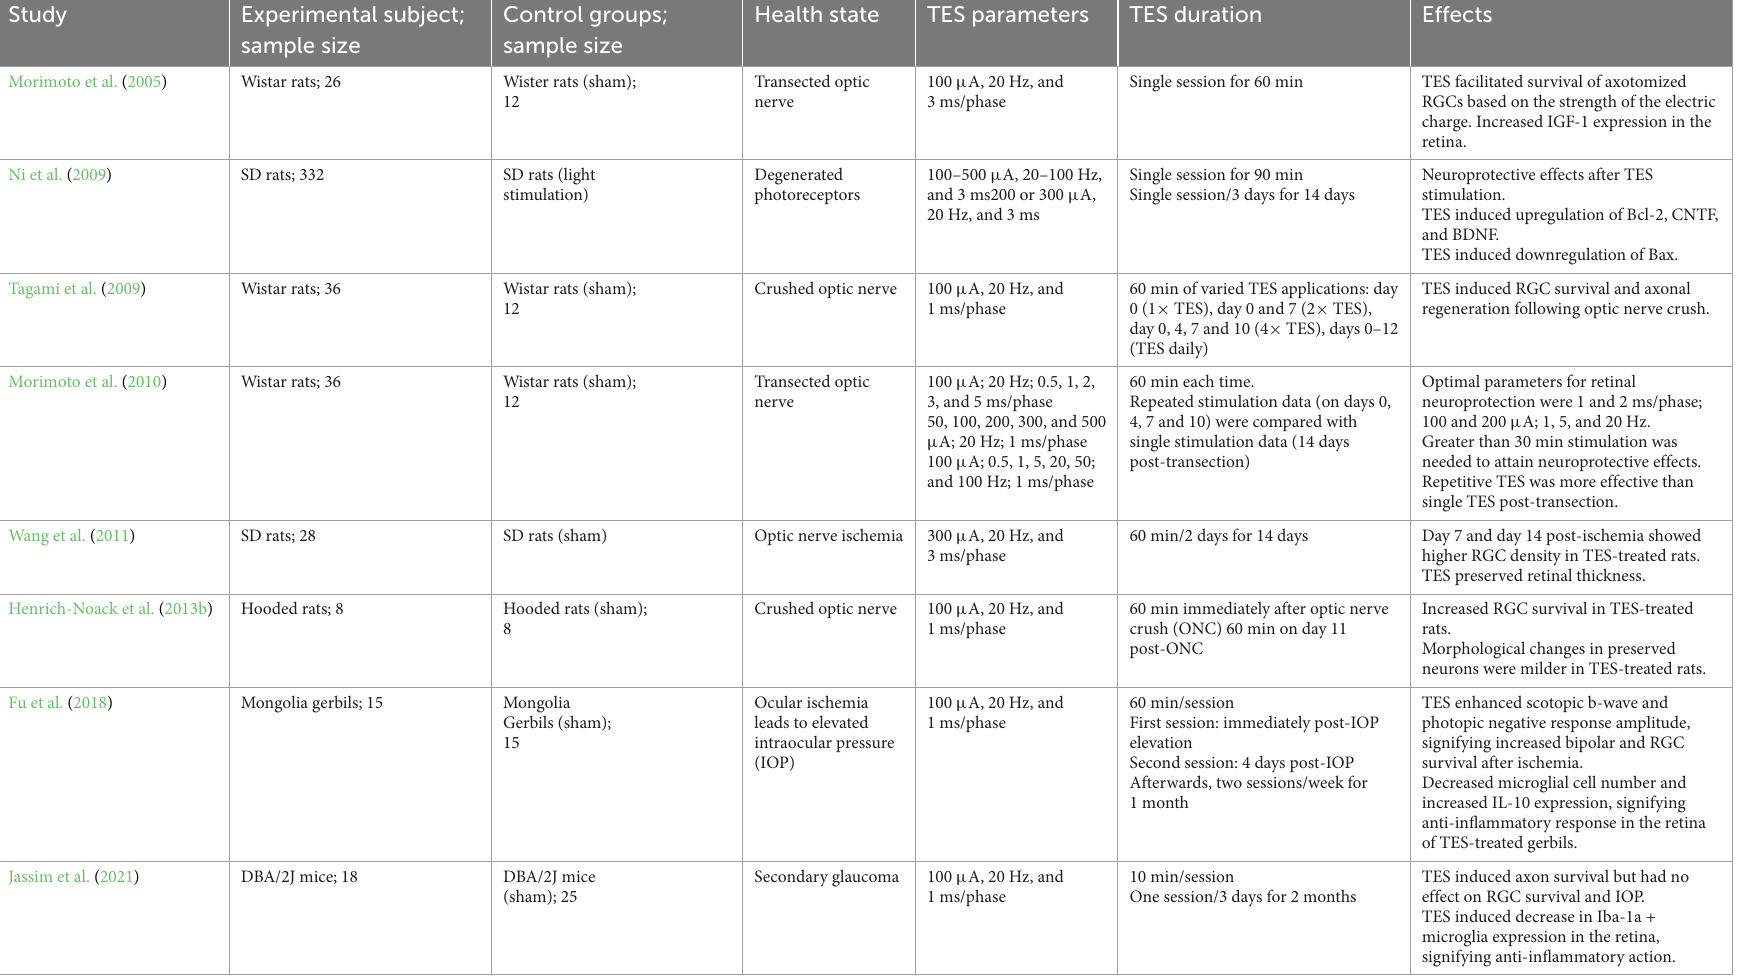
TABLE 1 Summary of preclinical studies on the effects of TES of the